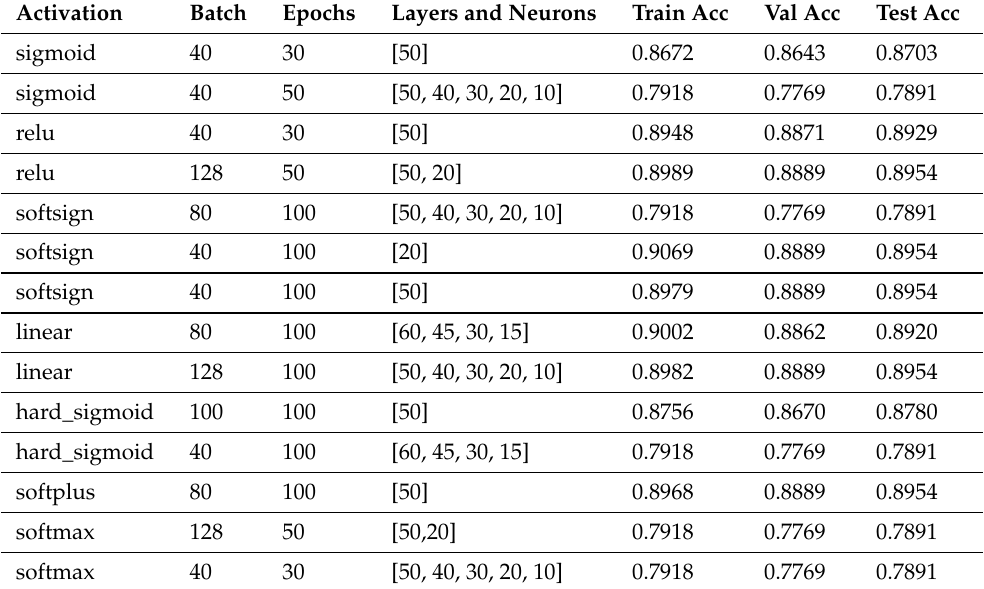
Table 1. Hyper-parameter